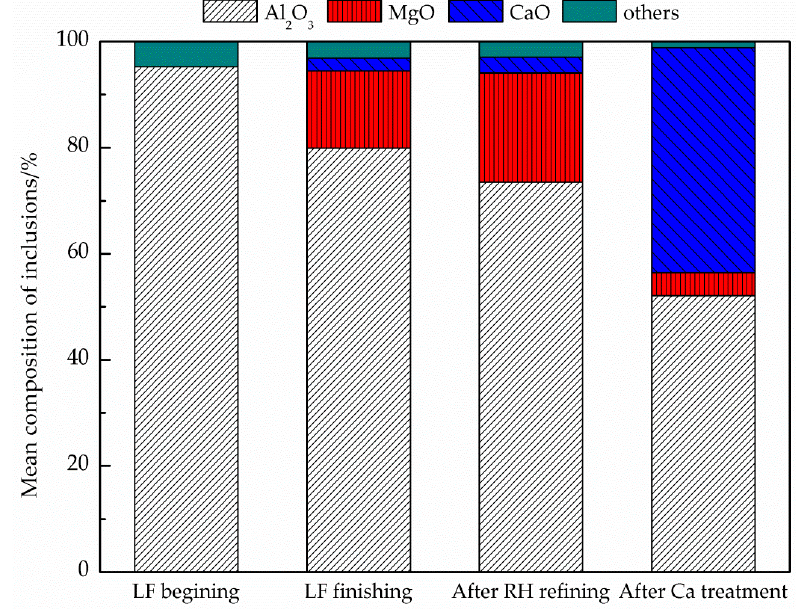
Figure 5. Evolution of mean mass fraction of inclusions.